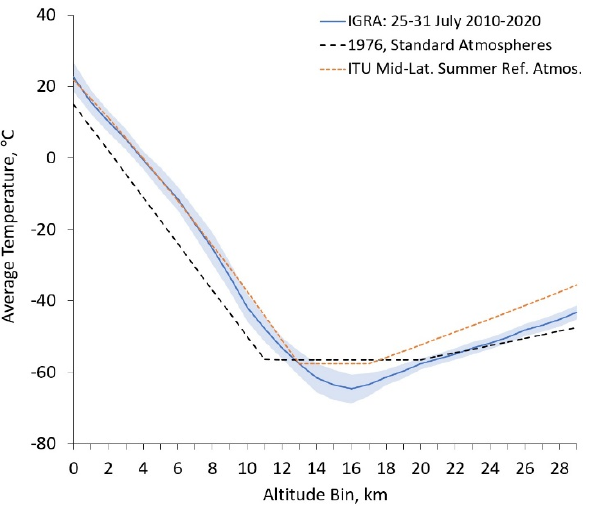
Figure 9. A comparison of the average temperature vertical profile obtained from IGRA for our decade-long, 7-day window with standard deviations shown as a blue shaded region, 1976 U.S. standard atmospheres (black dashed line), and the ITU Radiocommunication Assembly mid-latitude summer reference atmosphere (orange dotted line).